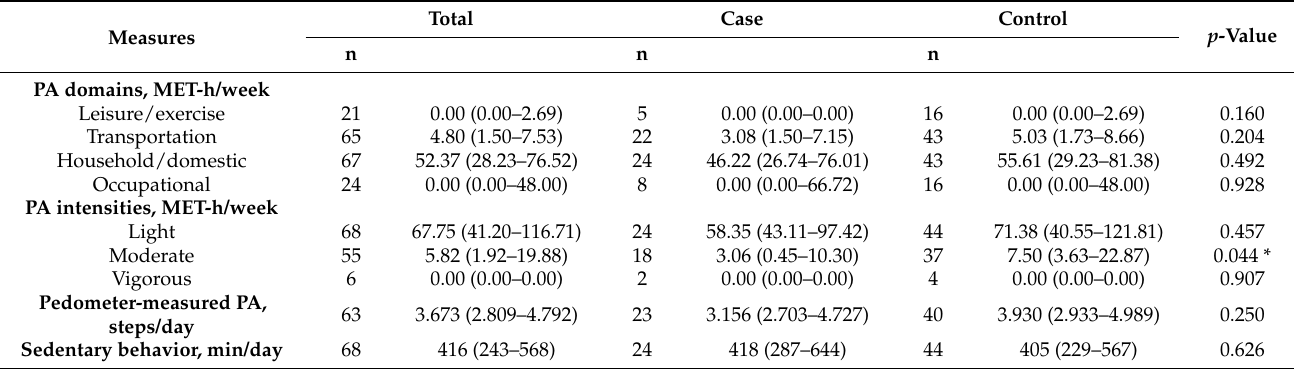
Table 2. Physical activity and sedentary behavior measures during pregnancy of case and control participants.